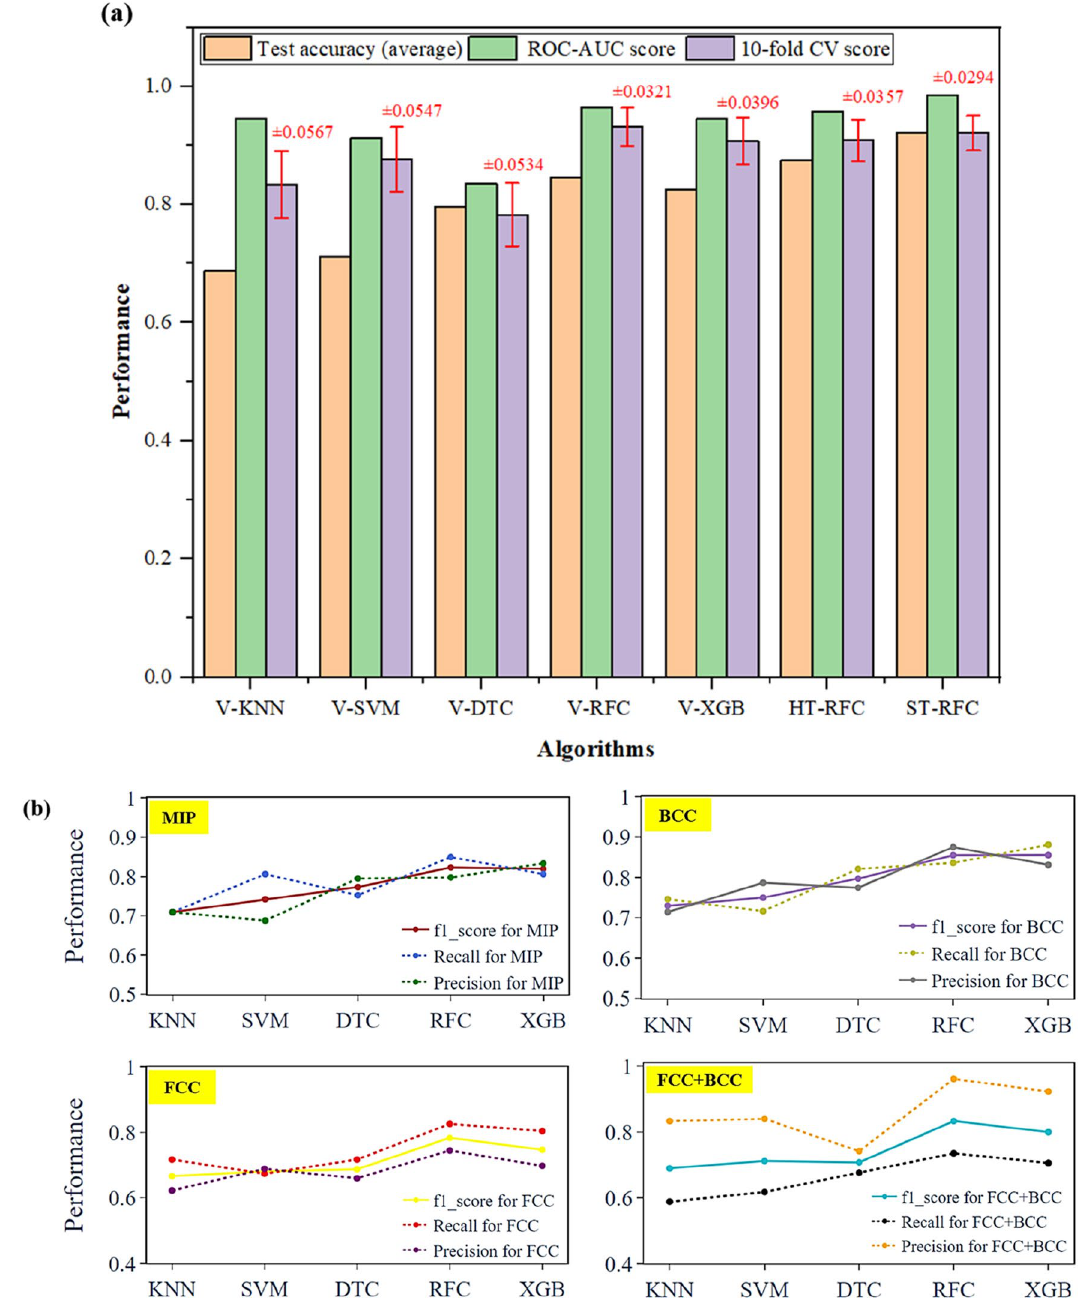
Figure 4. ( a ) Performance comparison of V-KNN, V-SVM, V-DTC, V-RFC, V-XGB, HT-RFC, and ST-RFC models using average test accuracy (multiply by 100 for % value), ROC_AUC score, tenfold cross-validation score and its standard deviation (values shown in red color), ( b ) F1-score, Recall and Precision for four distinct phases of HEAs for five vanilla